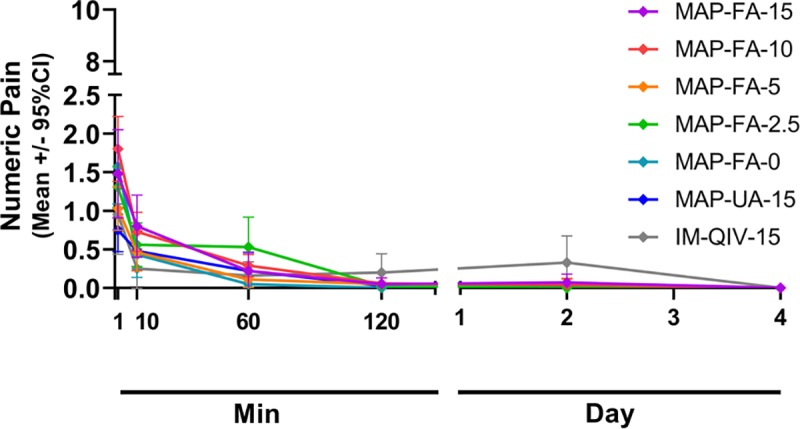
Self-reported pain scores using a visual analogue scale from 0 (no pain) to 10 (worst pain imaginable).Symbols represent mean scores ± 95% confidence intervals. Day, study day (HD-MAP applied on day 1); HD-MAP, high-density microarray patch; Min, minutes after HD-MAP application.